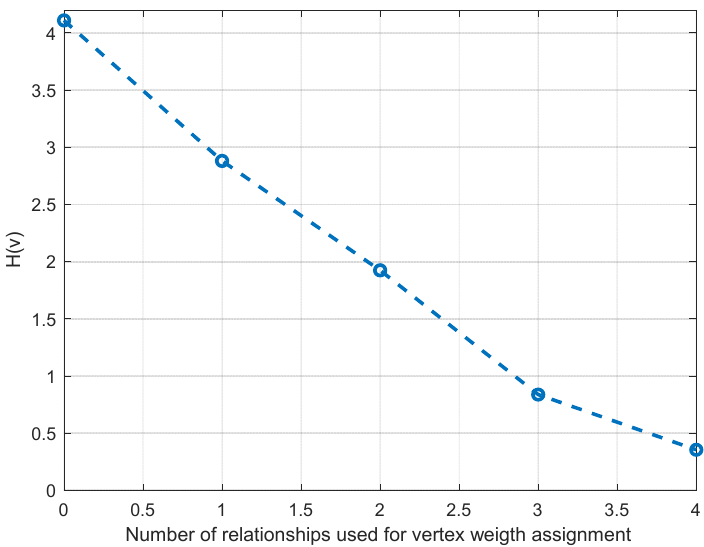
Figure 4. Location entropy for three ANs scenarios using different relational stages.